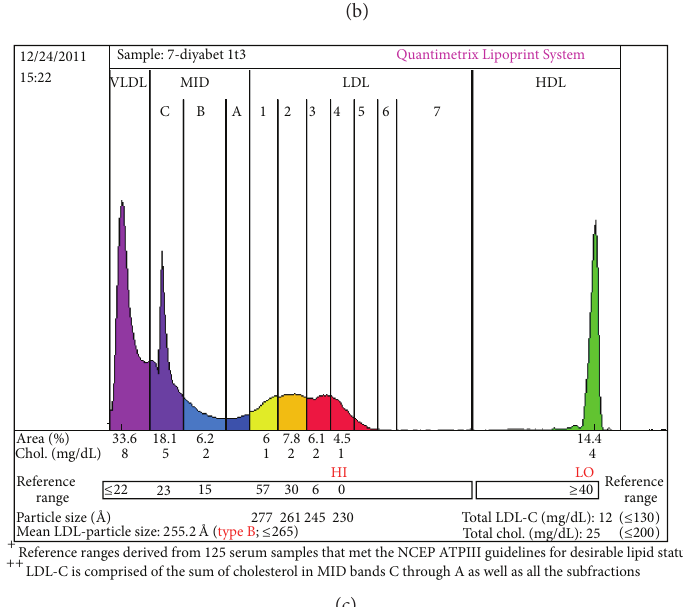
Figure 1: Electrophoretic separation of lipoproteins on the Quantimetrix Lipoprint LDL System. (a) Image of electrophoretic migration of 10 gel tubes. C: control; D: diabetes. (b) Densitometric scan of a control sample, gel tube C1. (c) Densitometric scan of a diabetic sample, gel tube